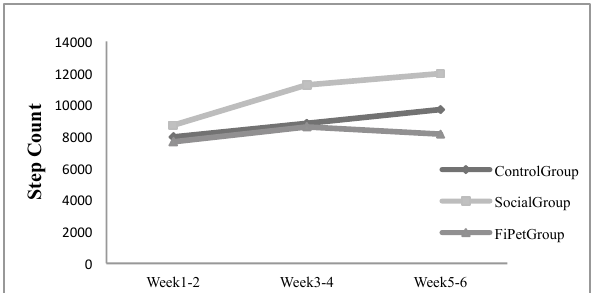
Figure 7. Physical Activity Changes of Three Groups during the Six-week Field Study